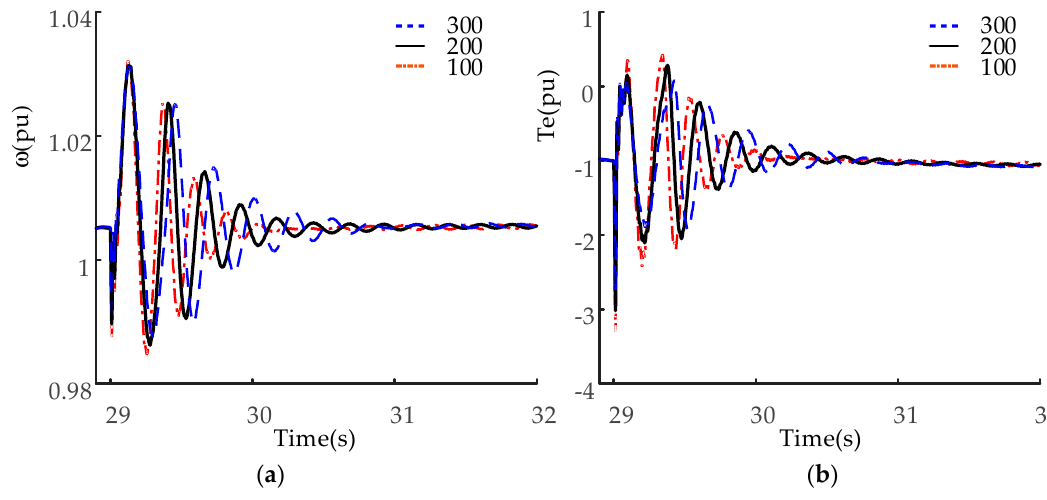
Figure 14. Impact of the three-phase ground fault for different wind farm capacity ( a ) Rotational speed ( b ) Electromagnetic torque.